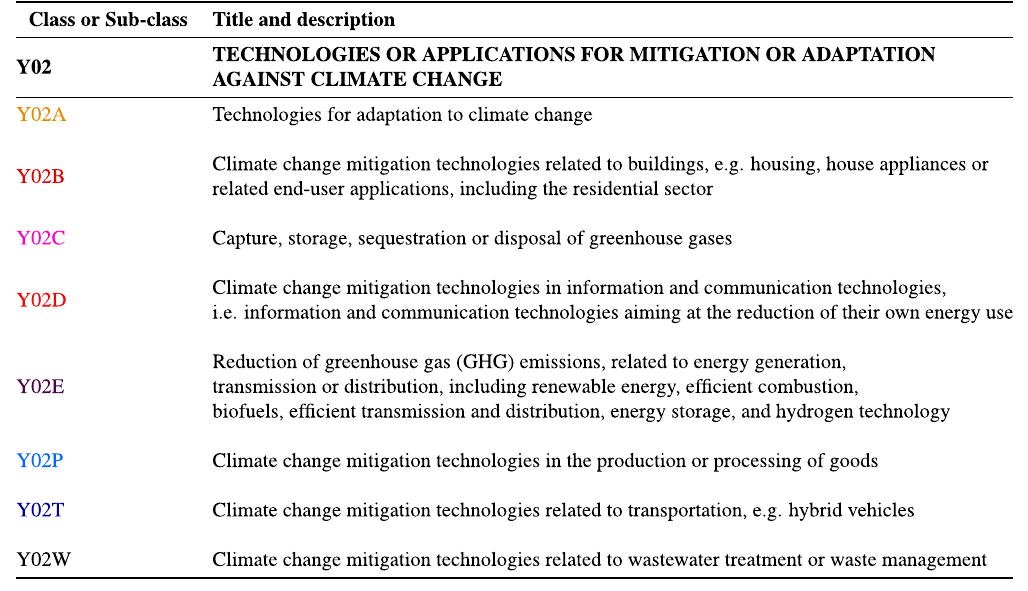
Table 1. CPC Y02 tagging scheme. Source: EPO 62 . In the first column the CPC code identifying the Y02 technology sub-class is reported. The second column reports the corresponding